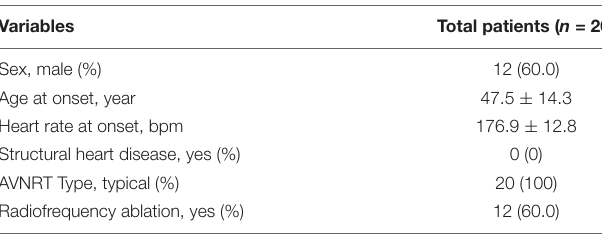
TABLE 1 | Demographic baseline of